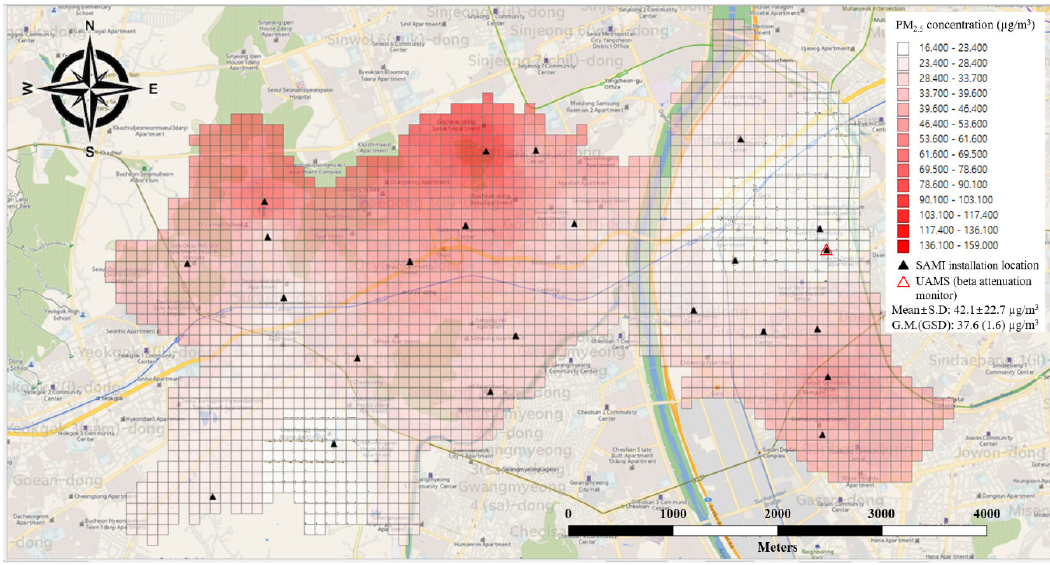
Figure 5. Spatial variation of modeled outdoor PM 2.5 concentration in Guro-gu.